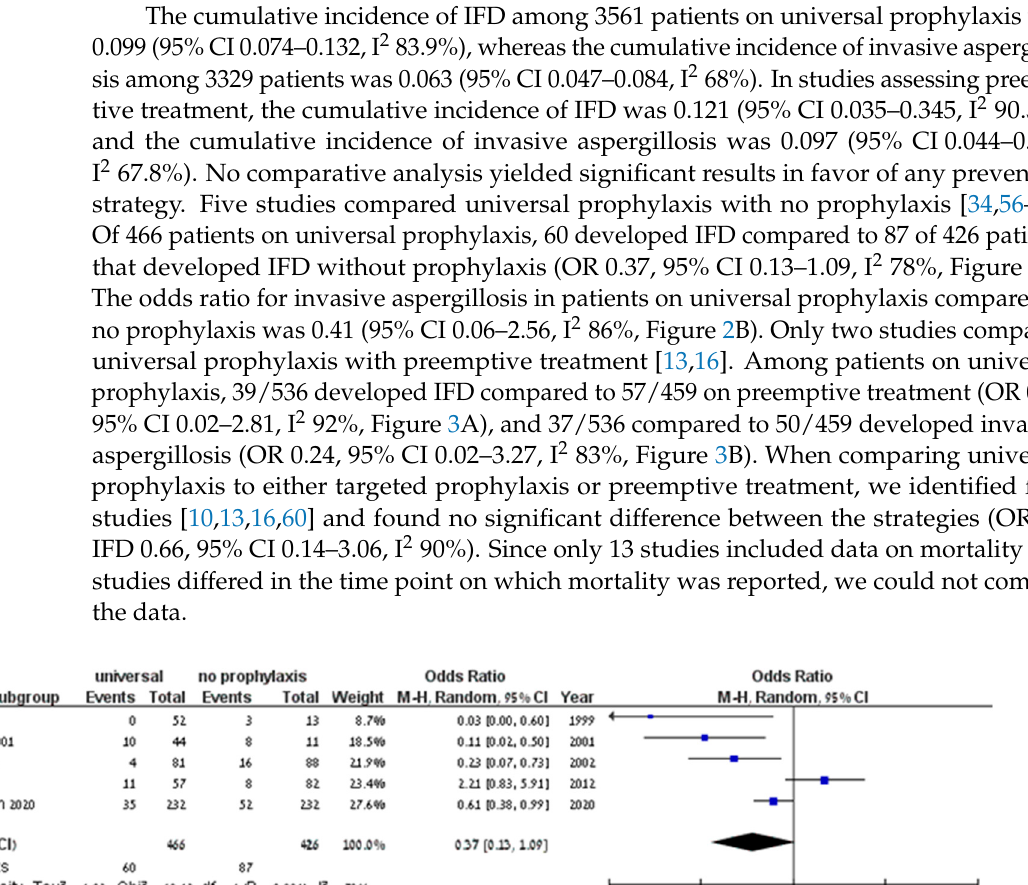
Figure 3. Invasive fungal disease ( A ) and invasive aspergillosis ( B ) in studies comparing universal prophylaxis and preemptive treatment.